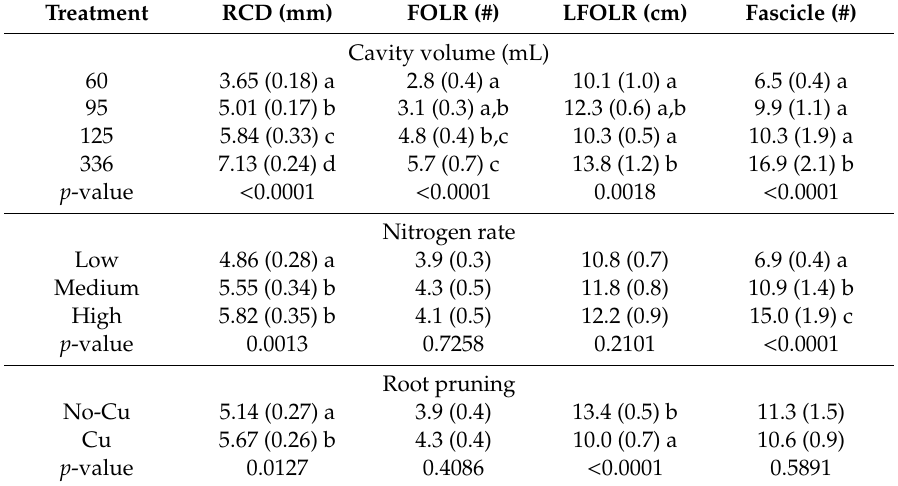
Table 1. Means (1 standard error of the mean, SE) and p -values for seedling root collar diameter (RCD), number (#) of first-order lateral roots (FOLRs), length of longest FOLR (LFOLR), and fascicle number in response to nursery treatments at the end of nursery production. Within each treatment, means for each variable followed by the same letter are not significantly di ff erent at the Bonferroni-adjusted 0.05 level.